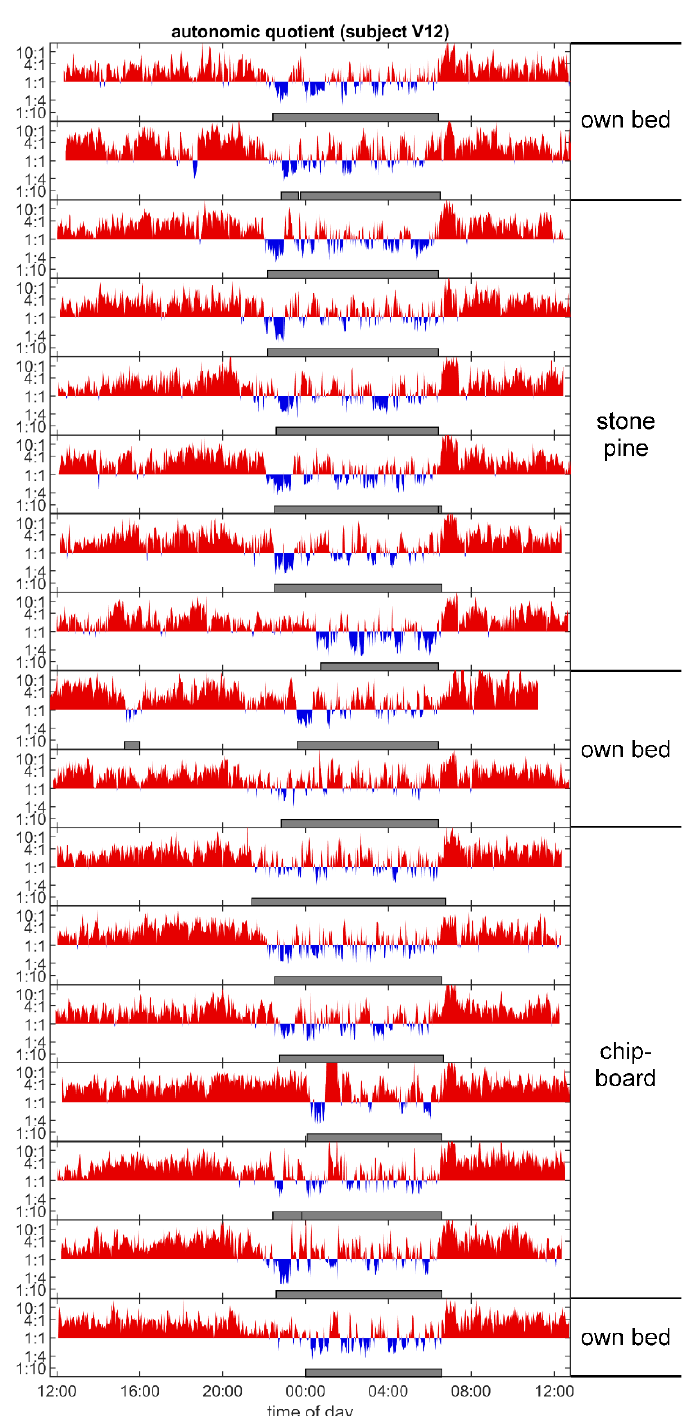
Figure 7. Example of the circadian and ultradian changes in the autonomic quotient over all measured nights for one subject (Number 12) during the study. After two measurements were made in their own bed, six measurements over three weeks were made in the stone pine bed. Two measurements were then made over the six-week washout period in their own bed, then another six measurements over three weeks were performed in the control bed (chipboard). The last measurement was made in the subject’s own bed again. Sympathetic predominance is shown in red, and vagal predominance, in blue. Especially during the period in the stone pine bed, the first non-REM (core sleep) phases are more rhythmic and more vagal (blue) than under the control (chipboard) bed conditions.